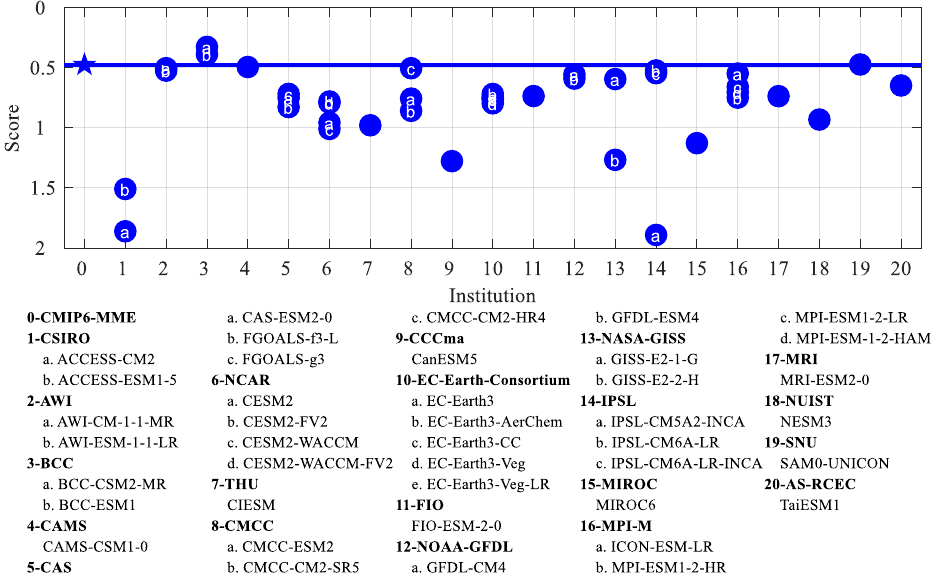
Figure 5. Taylor Diagram Score of the simulated sea surface salinity (SSS) in the Asia Marginal Seas (AMSs). Blue pentagrams indicate the CMIP6 multi-model ensemble means (MMEs), with scores of 0.47. The sequence numbers from 1 to 20 are affiliated with the institutions listed in Table 1.